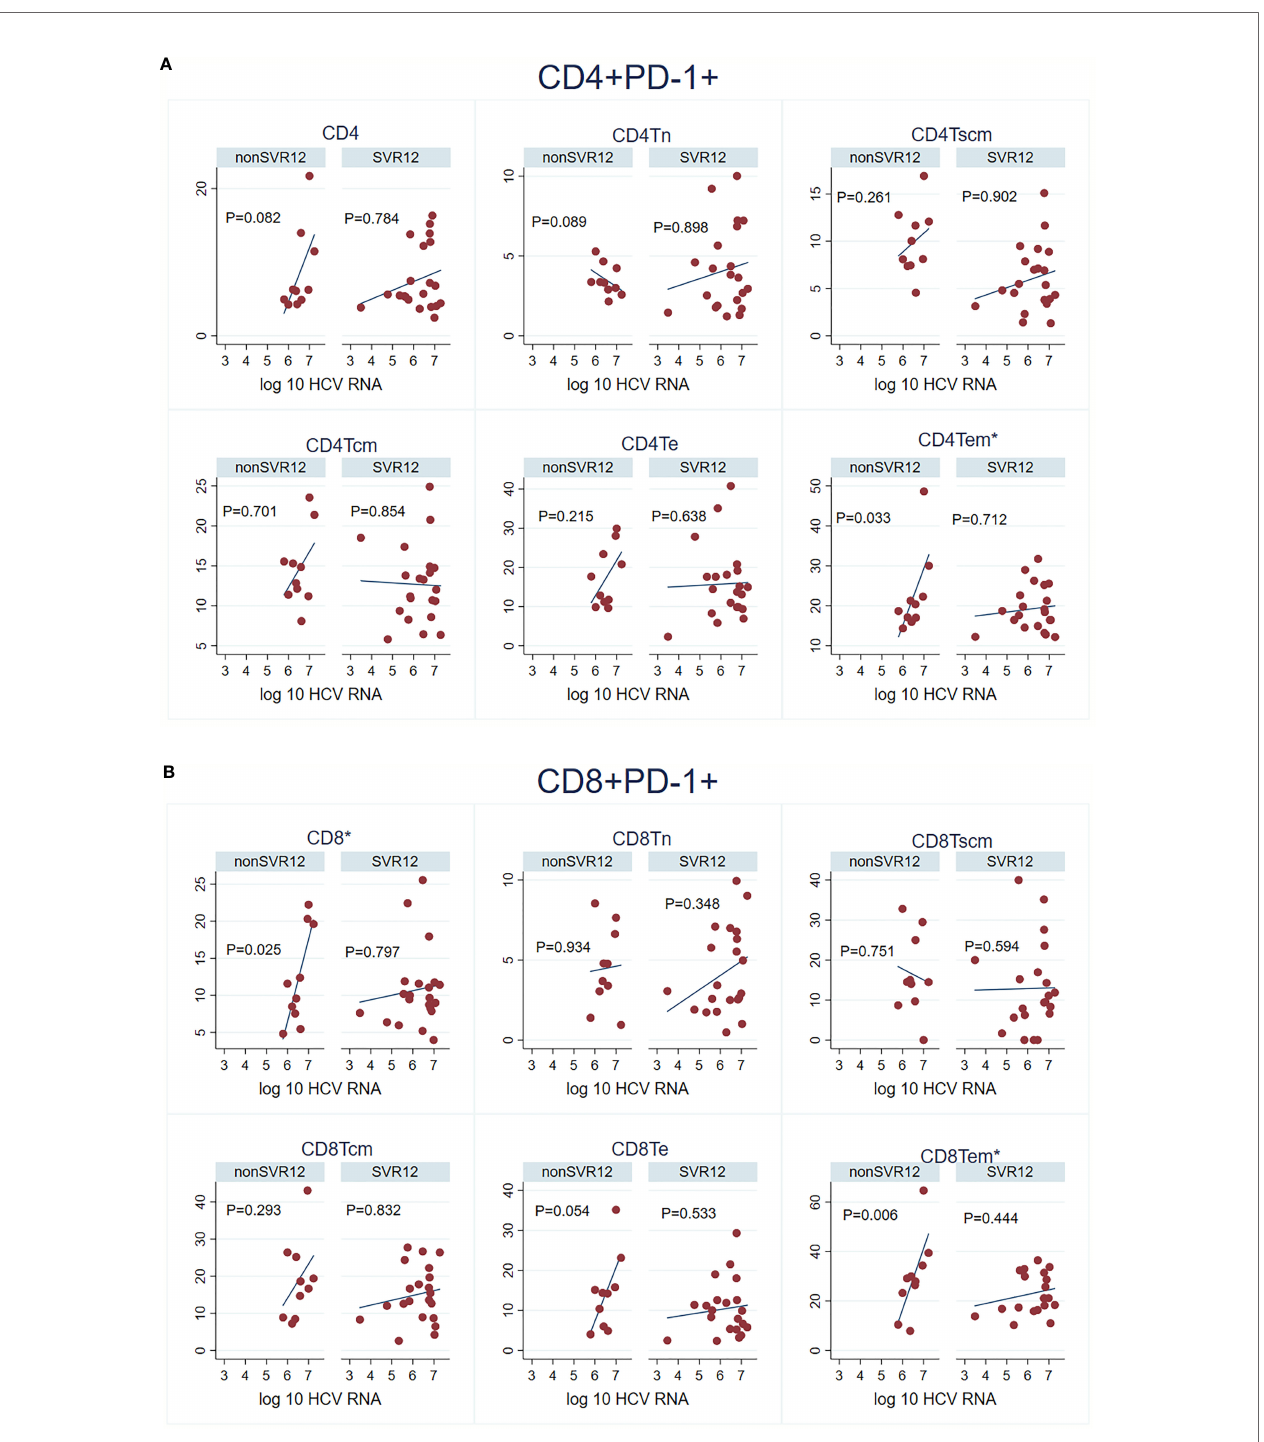
FIGURE 3 | Viral load and the expression of PD-1 by baseline for the different subset of T-cells divided for patients who achieved SVR12 and virological relapse. (A) CD4 + PD-1 + and HCV RNA. (B) CD8 + PD-1 + and HCV RNA. Sustained virological response (SVR); naïve T cells (Tn); stem cell memory T-cells (Tscm); T central memory cell (Tcm); terminal effector T-cells (Te); T effector memory cell (Tem). Signi fi cant values marked with